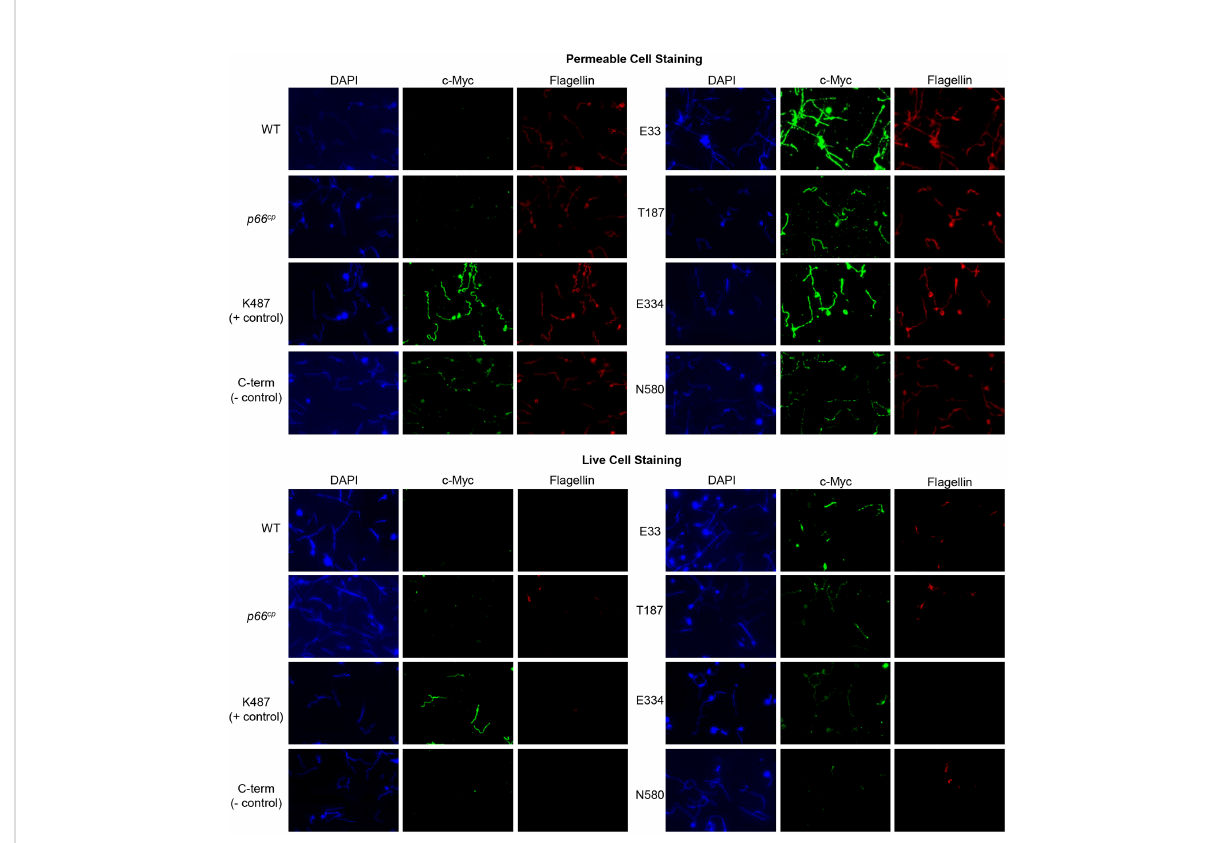
FIGURE 4 Immuno fl uorescence microscopy demonstrates surface localization of c-Myc-tagged P66 domains. Top: Permeable cell staining. B313 c-Myc P66 cp cells were permeabilized with ice-cold acetone, probed with anti-c-Myc and anti- fl agellin antibodies, stained with DAPI, and mounted in Pro-Long Diamond mounting media. Bottom: Live cell staining. Cells were probed with anti-c-Myc and anti- fl agellin antibodies, fi xed with ice- cold acetone, stained with DAPI, and mounted in Pro-Long Diamond mounting media. Immuno fl uorescence microscopy images were taken at 100x oil immersion. Images are representative of at least 3 independent